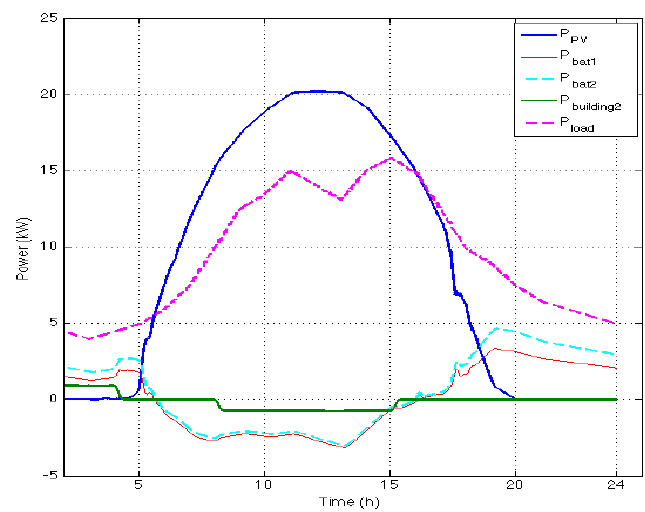
Figure 10. DC microgrid configuration of a building.